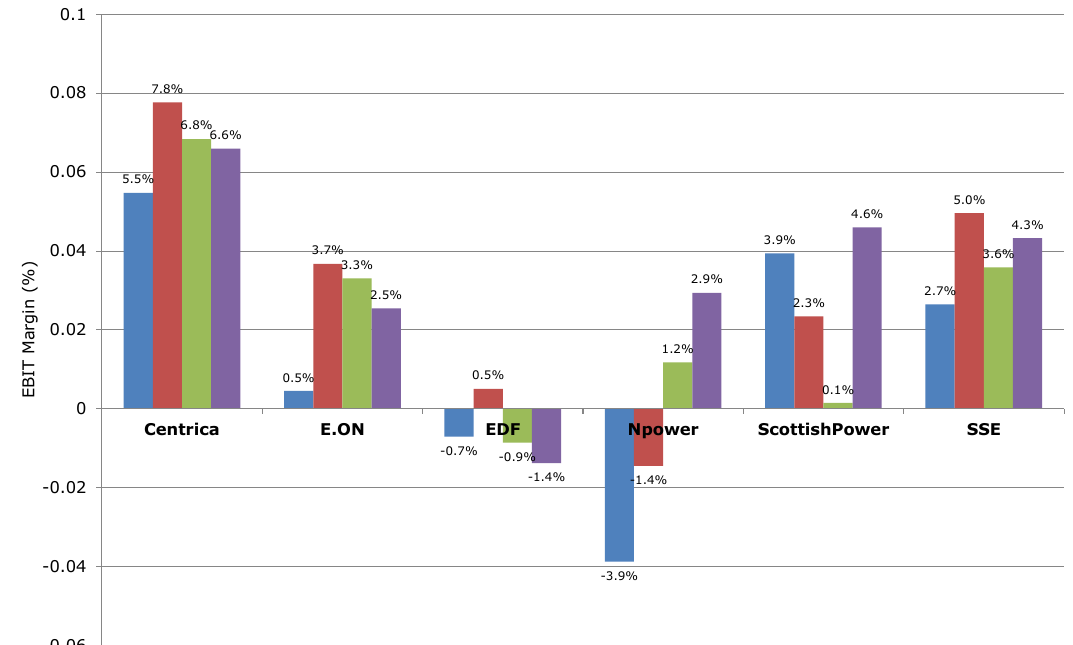
Figure 46: Six largest suppliers Combined Retail Business Electricity and Gas Supply EBIT Margins (% of